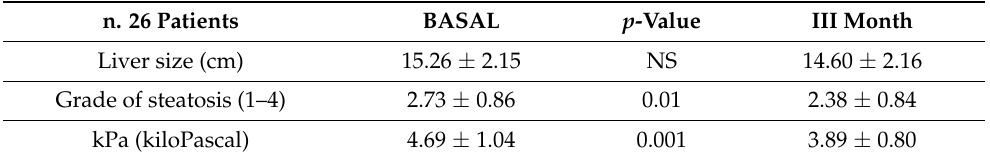
Table 3. Ultrasound and elastosonographic parameters before and after lifestyle modifications (Mean ± Standard Deviation).